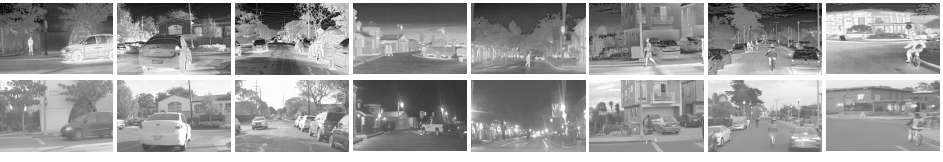
Figure 4. Illustrations of 8 pairs of testing images of the RoadScene